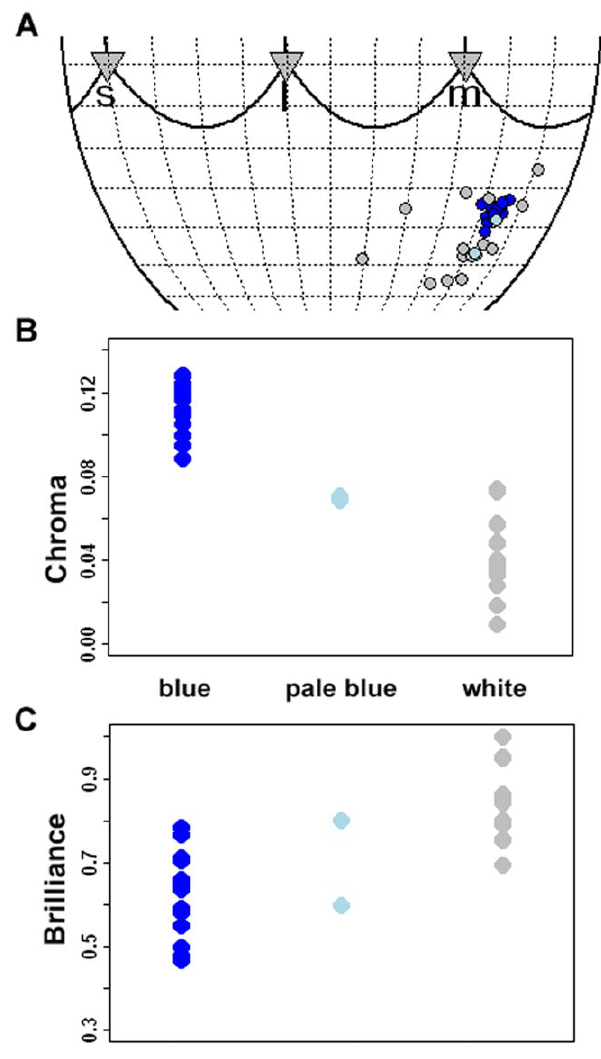
Figure 1. Aspects of colour and brightness of ashy-throated parrotbills eggs. Blue, light blue and grey points indicate blue (16 eggs), pale blue (3 eggs) and white (15 eggs) egg morphs. (A) Robinson projection of egg colour hues. Grey triangles indicate projections of the short (s), medium (m) and long (l) wavelength vertices of the tetrahedron. For illustration clarity, only the bottom part of the sphere is shown, and hence the projection of the ultraviolet (uv) wavelength projection is omitted. (B) Chroma or colour saturation. (C) Normalized brilliance as a measure of achromatic brightness. See Results for more detailed descriptions.